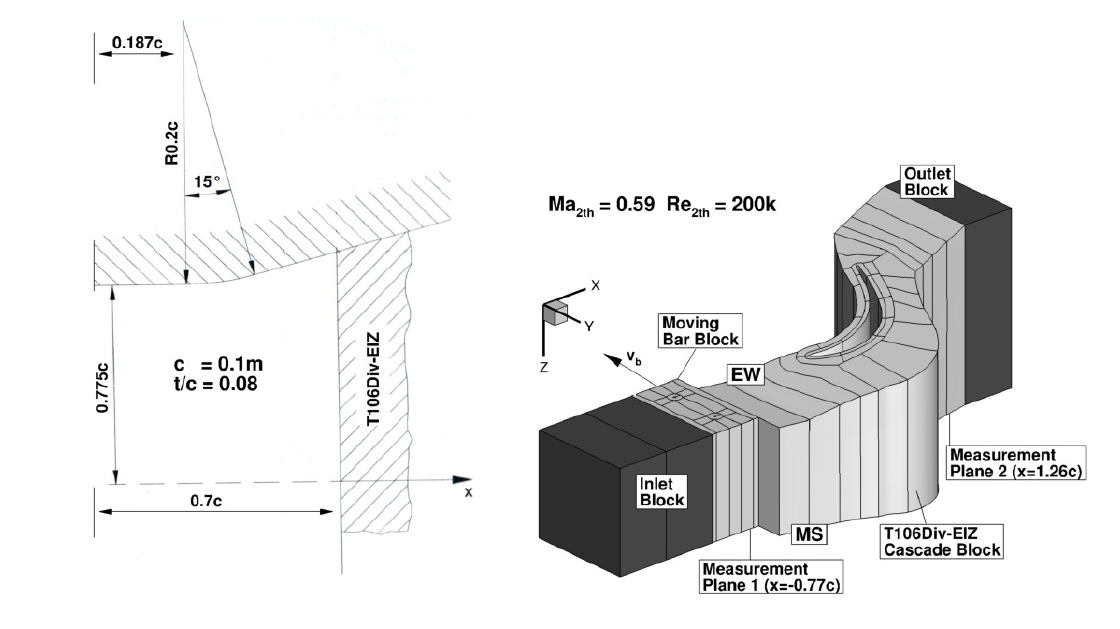
Figure 1. Geometry of the T106Div-EIZ inlet region and the modeled numerical